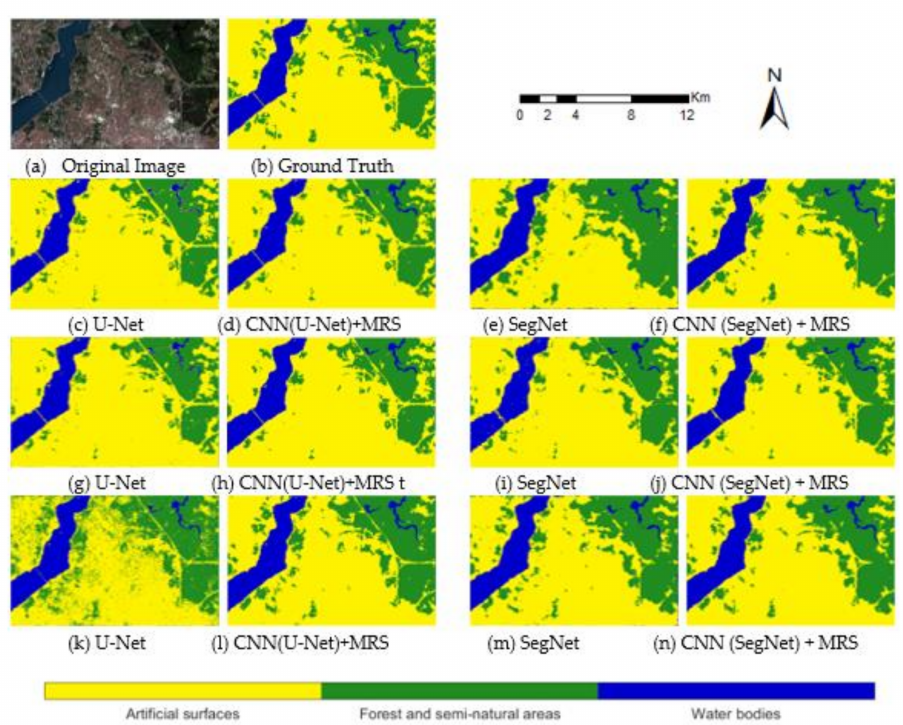
Figure 13. Istanbul test area results of CNN models and CNN–MRS models with 7-band dataset ( c – f ): 32 × 32 patch size; ( g – j ): 64 × 64 patch size; ( k – n ): 128 × 128 patch